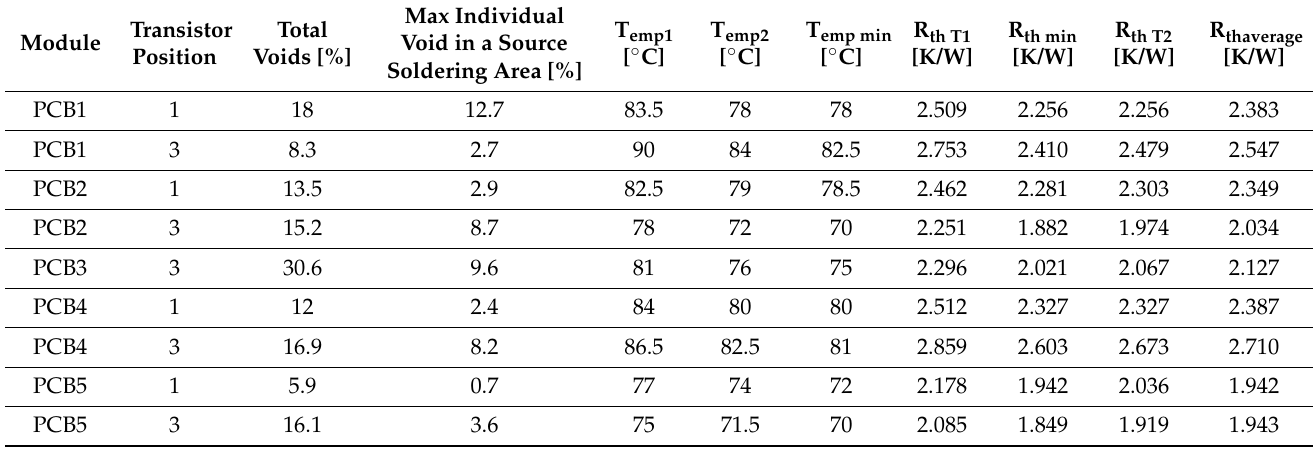
Table 1. Exemplary results of the measurements of temperatures T emp1 , T emp2 , T empmin measured on the case of the transistor BLC10G22LS-240PV in several electronic modules and in various mounting positions as well as the determined thermal resistances R thT1 , R thmin , R thT2 , R thaverage with the dissipated power P = 21.5 W and control voltage V GS = 3